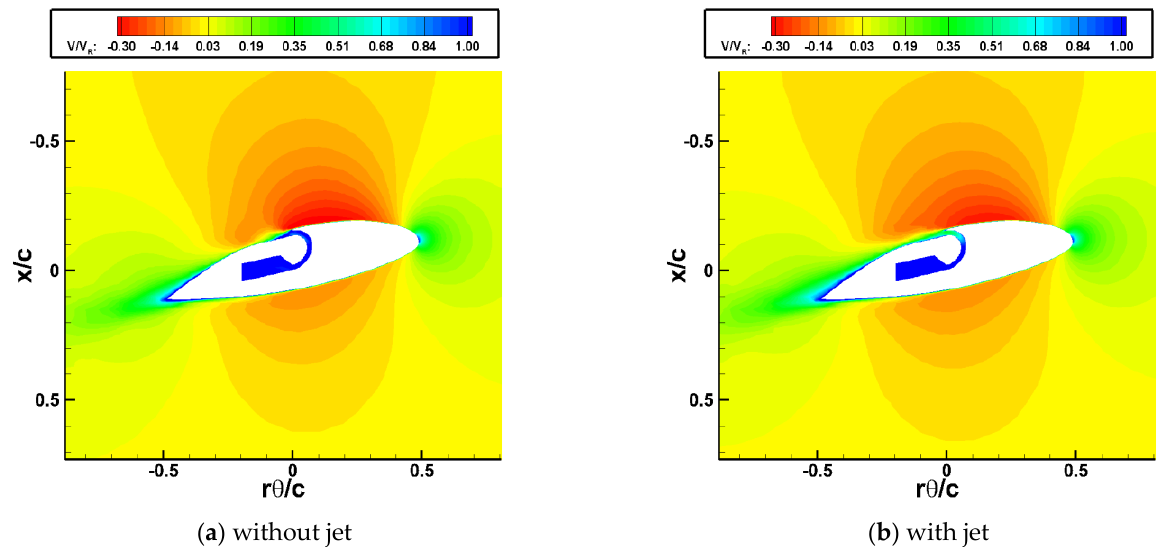
Figure 11. Tangential velocity distribution according to with and without jet injection (r/R = 0.73).